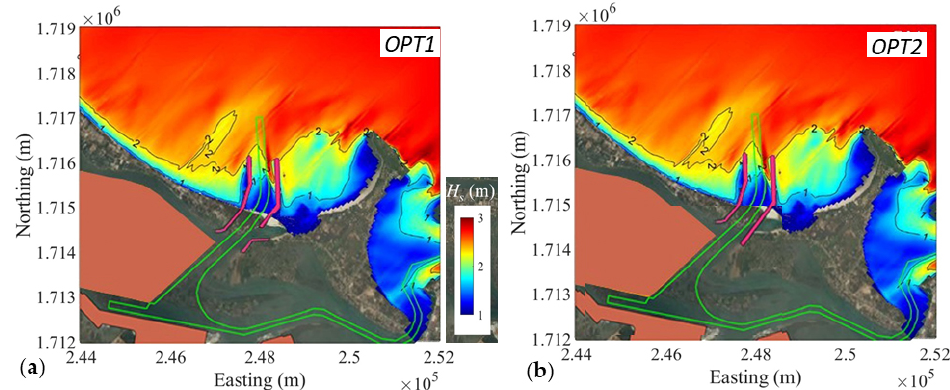
Figure 17. Wave field during the Northeast monsoon after jetty construction.